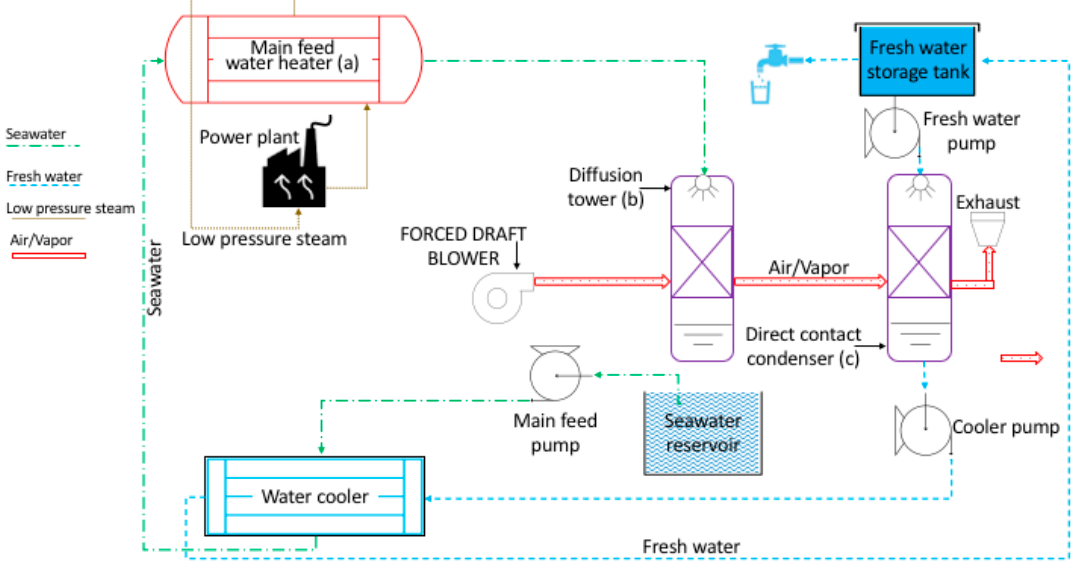
Figure 8. A schematic design of a diffusion-driven desalination (DDD) unit [306] .